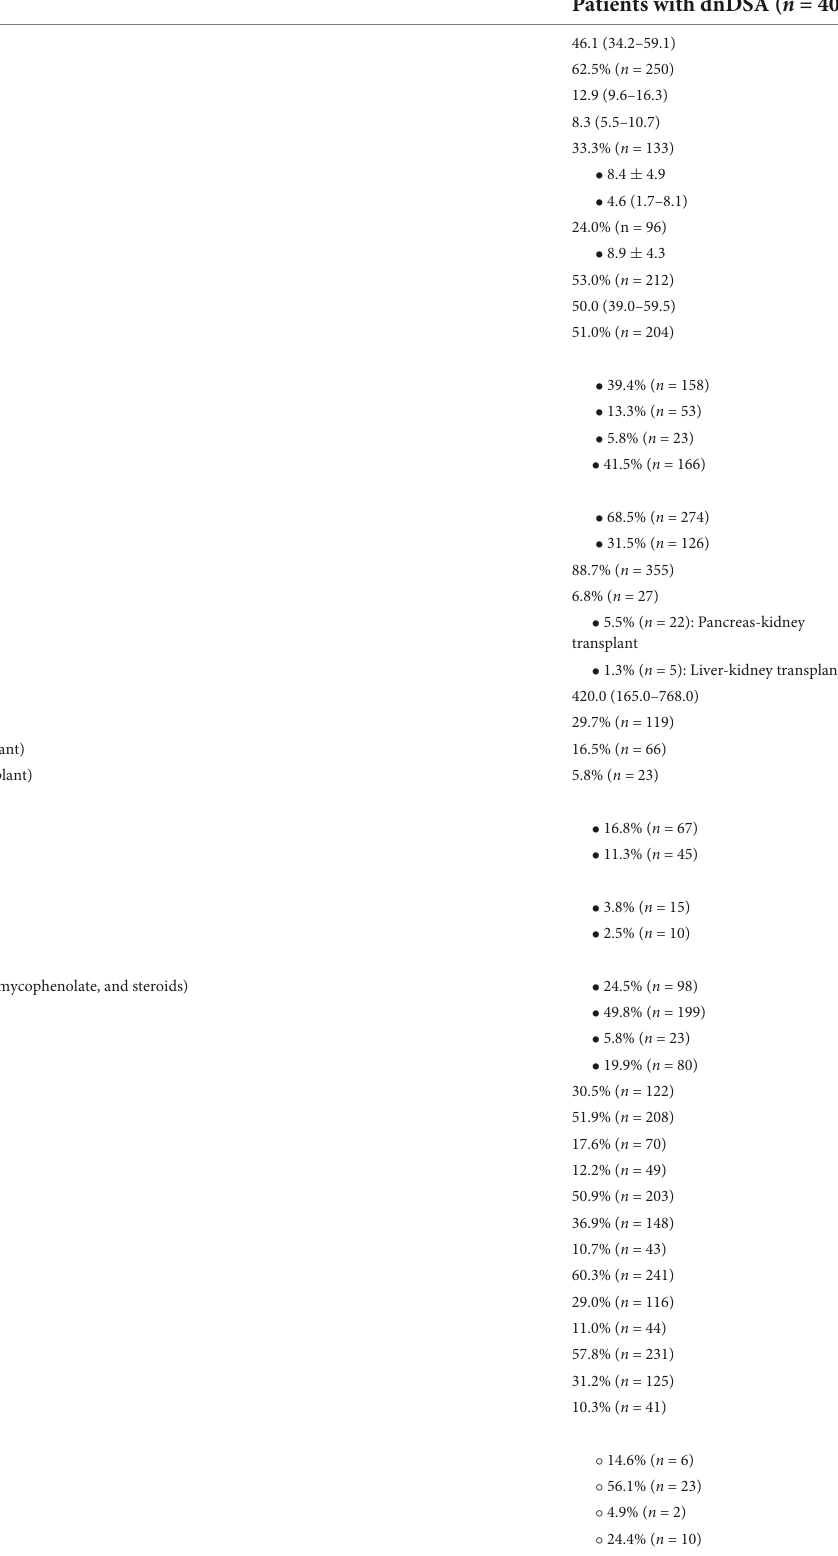
TABLE 1 Baseline characteristics of patients with